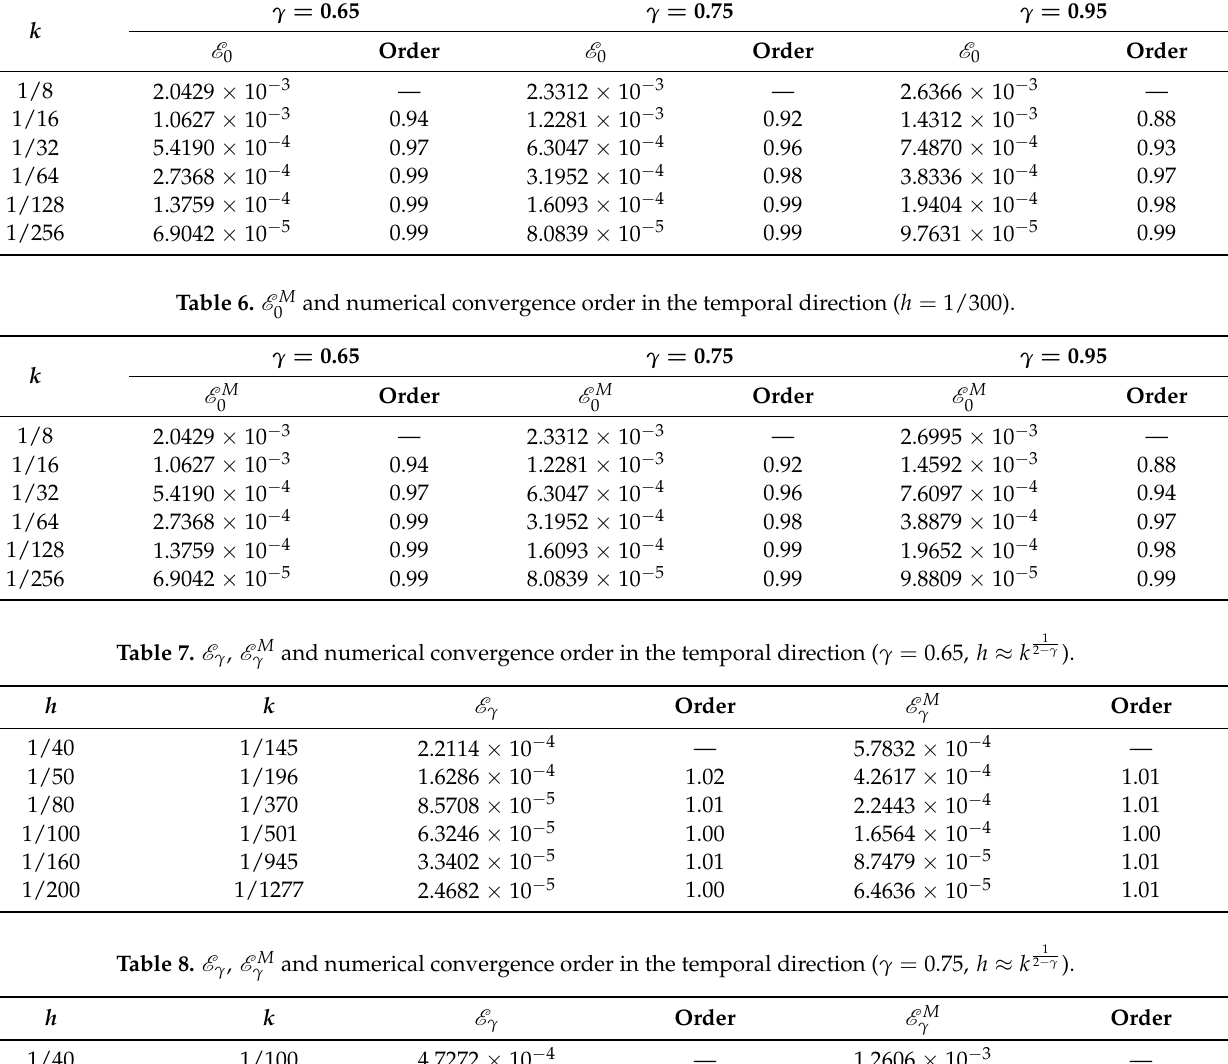
Table 5. E 0 and numerical convergence order in the temporal direction ( h = 1/300).